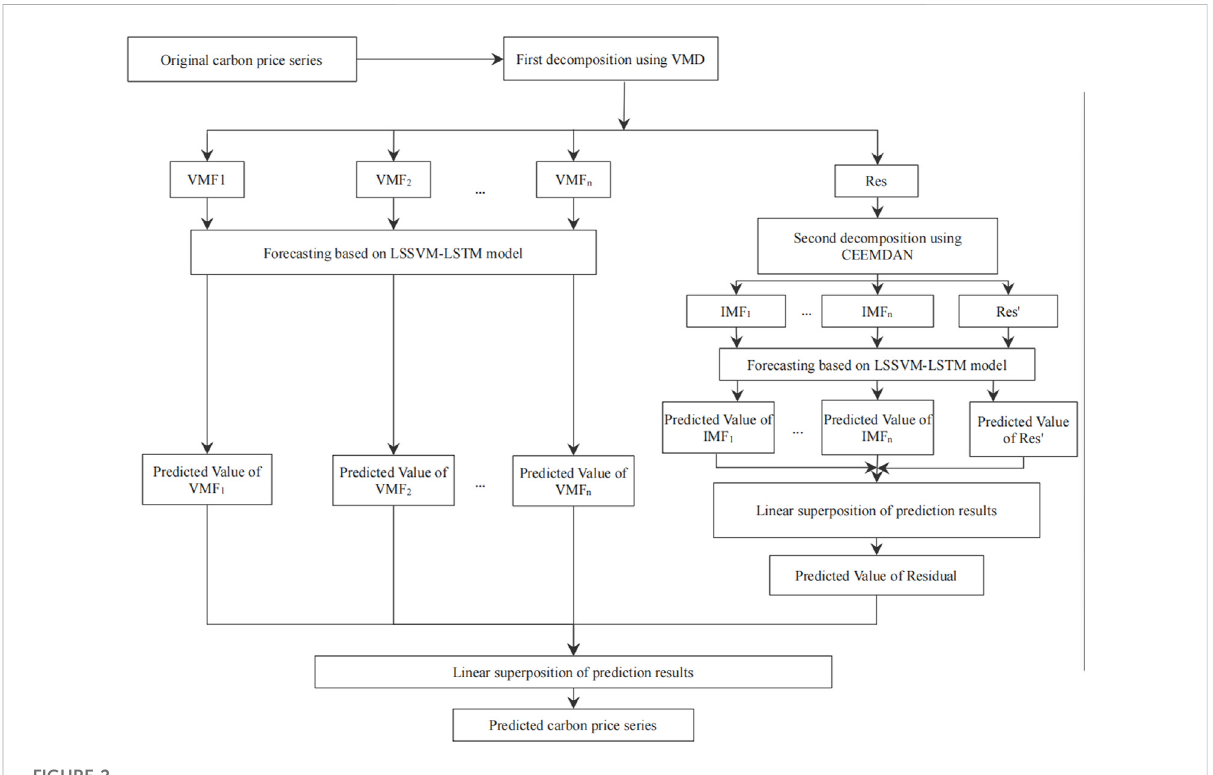
FIGURE 2 The main structure of the proposed model.